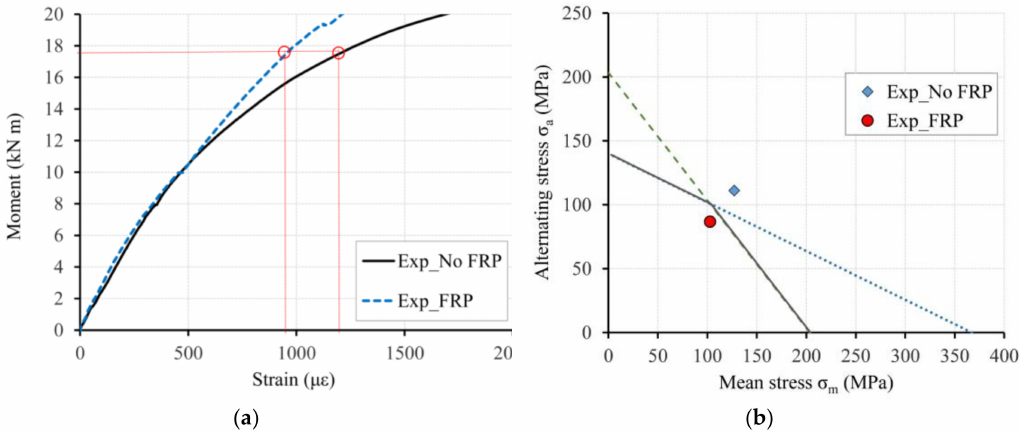
Figure 25. Comparison between CFRP-strengthened and non-strengthened connection (experimental tests). ( a ) Moment- principal strain curves. ( b ) Constant fatigue-life